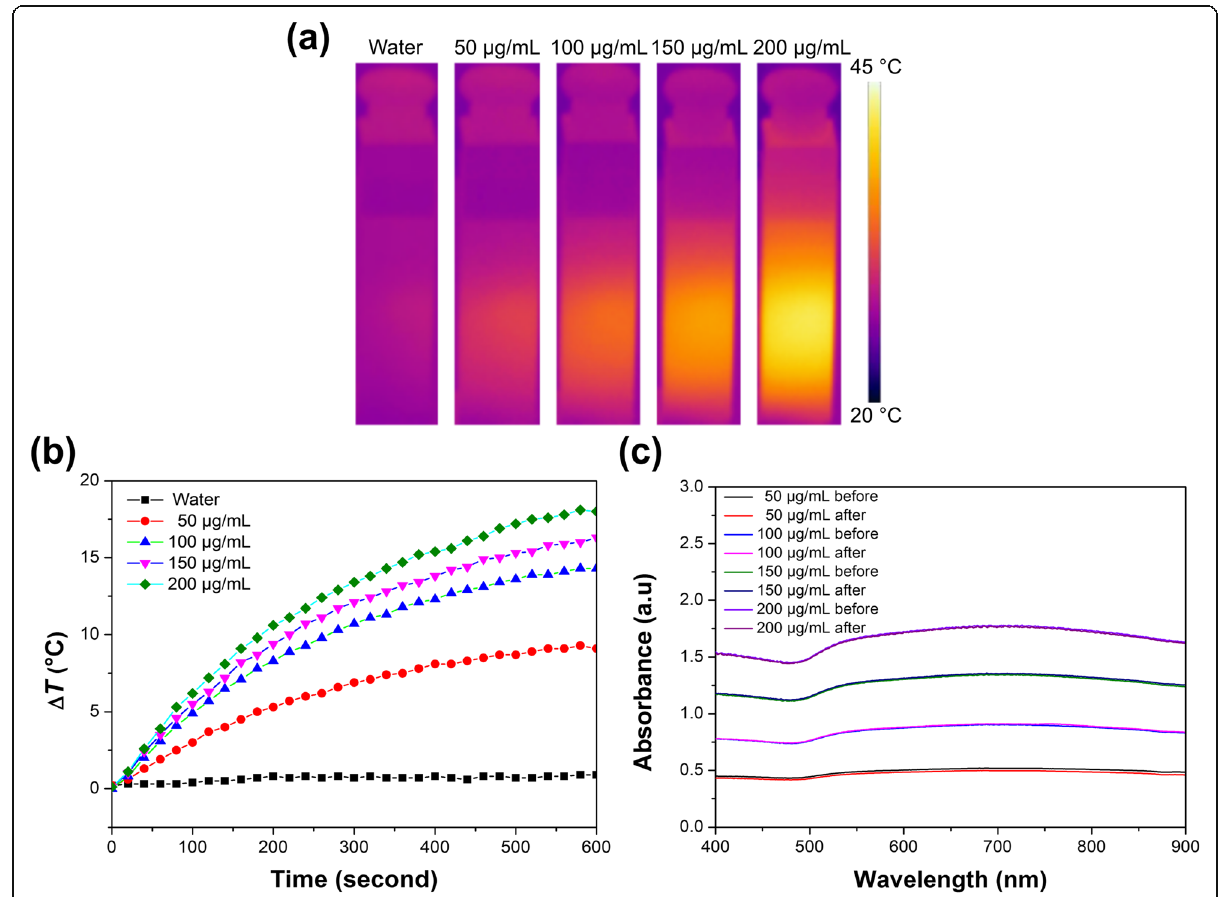
Fig. 4 Photothermal effect of Her2-GPH NPs. a NIR thermal images and b temperature variation of Her2-GPH NPs at different concentrations,